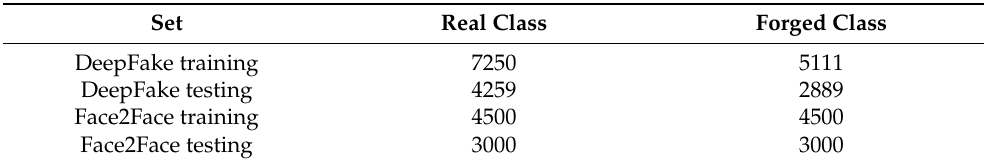
Table 2. The cardinality of each class in the studied datasets. Set Real Class Forged Class DeepFake training 7250 5111 DeepFake testing 4259